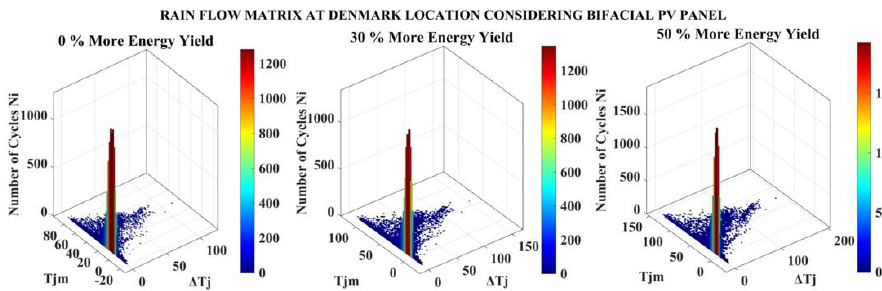
Figure 17. Rainflow matrix at the location in India.